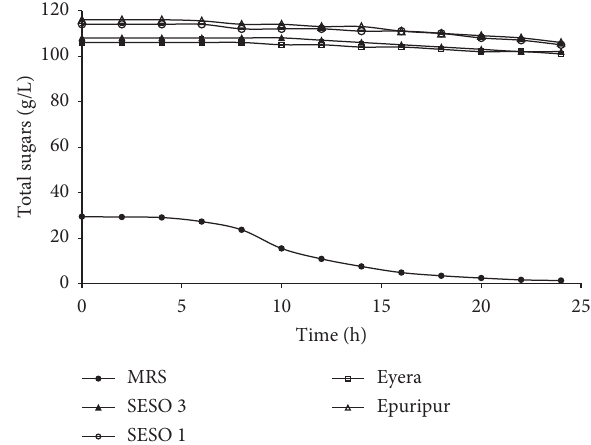
Figure 4: Changes in titratable acidity during growth of L. plantarum MNC 21 in MRS broth and malt extracts from different sorghum varieties. Error bars show standard deviations of three independent